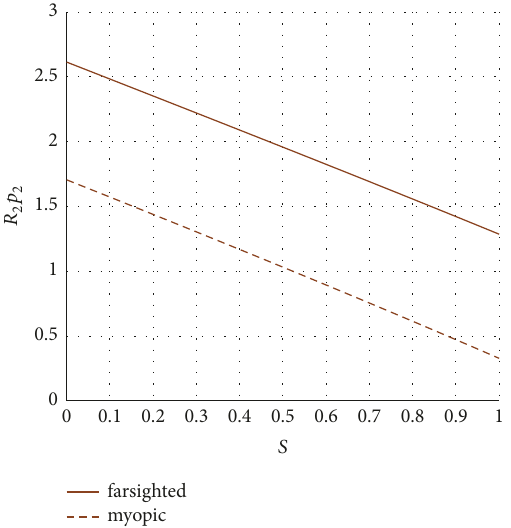
Figure 6: The emission-price product as 𝑆 increases.